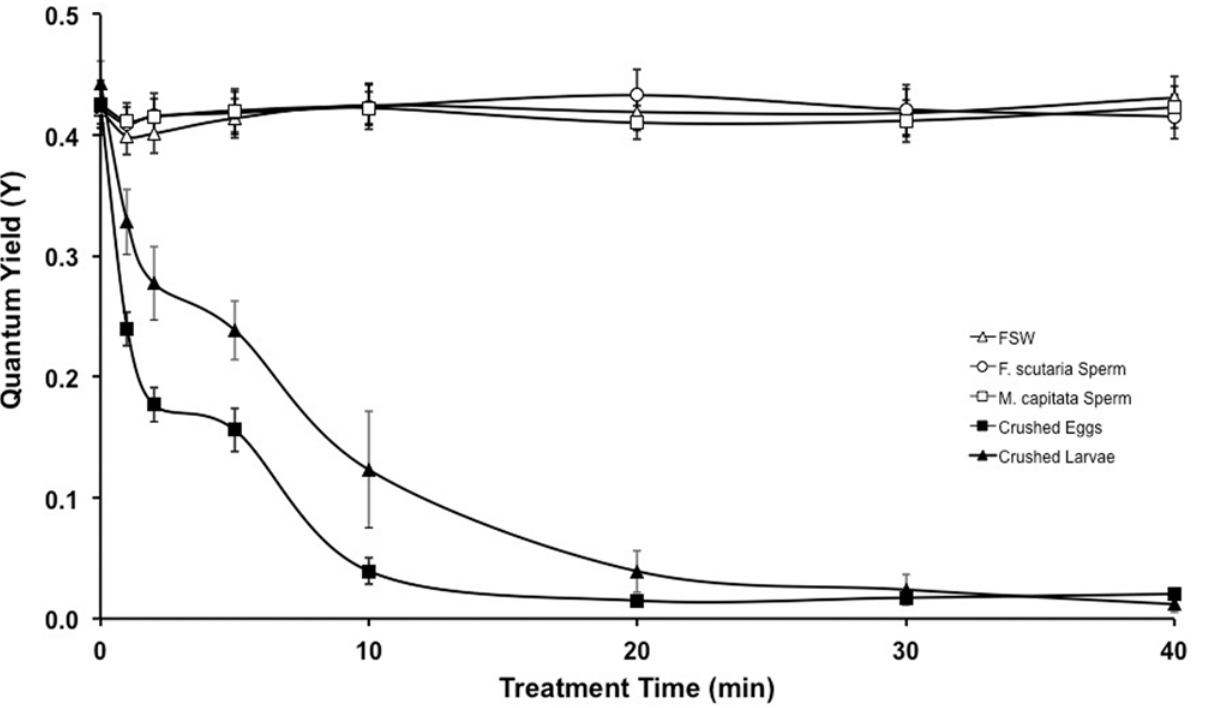
Fig 4. M . capitata sperm does not contain the same toxic properties as its eggs. P . compressa zooxanthellae from 8 individuals were split into 5 sub- samples and exposed to five different treatments: 1) frozen/thawed F . scutaria sperm , 2) frozen/thawed M . capitata sperm, 3) toxic eggs: frozen/thawed crushed M . capitata eggs, 4) frozen/thawed crushed M . capitata larvae, and 5) FSW. After 20 min, the crushed M . capitata eggs and larvae reduced quantum yield greater than 90% (P < 0.05), while the other treatments remained unchanged at 0.4 (P >